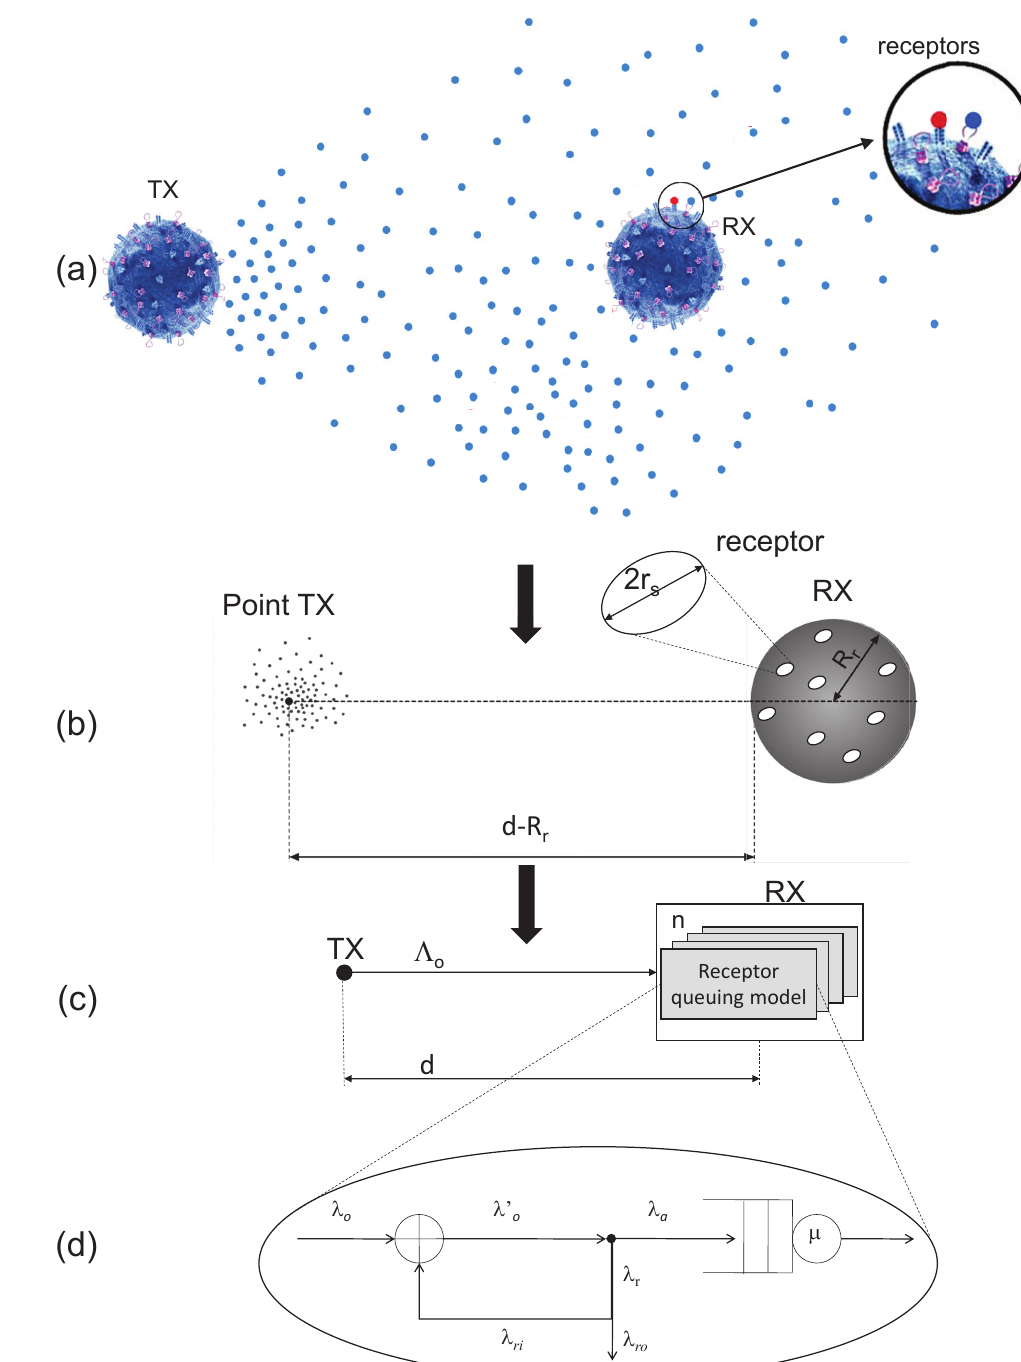
Figure 1. Overall system model: ( a ) emitting and receiving nanomachines with surface receptors, ( b ) equivalent molecular communications model with receptors of radius r s , ( c ) queuing model of the RX with all n receptors, and ( d ) queuing model for each